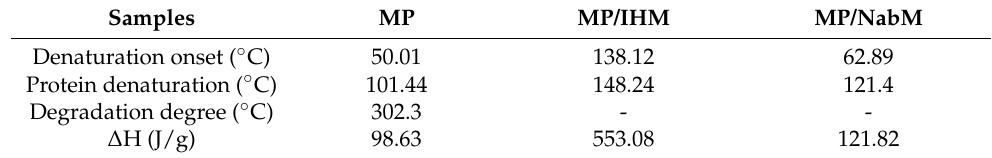
Table 2. Differential scanning calorimetry (DSC) parameters of MP and MPMC *.